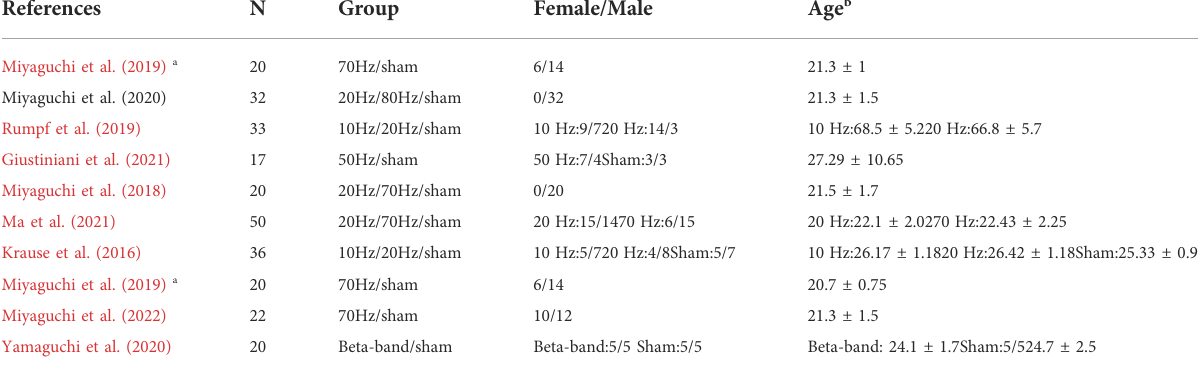
FIGURE 1 Study fl ow diagram.